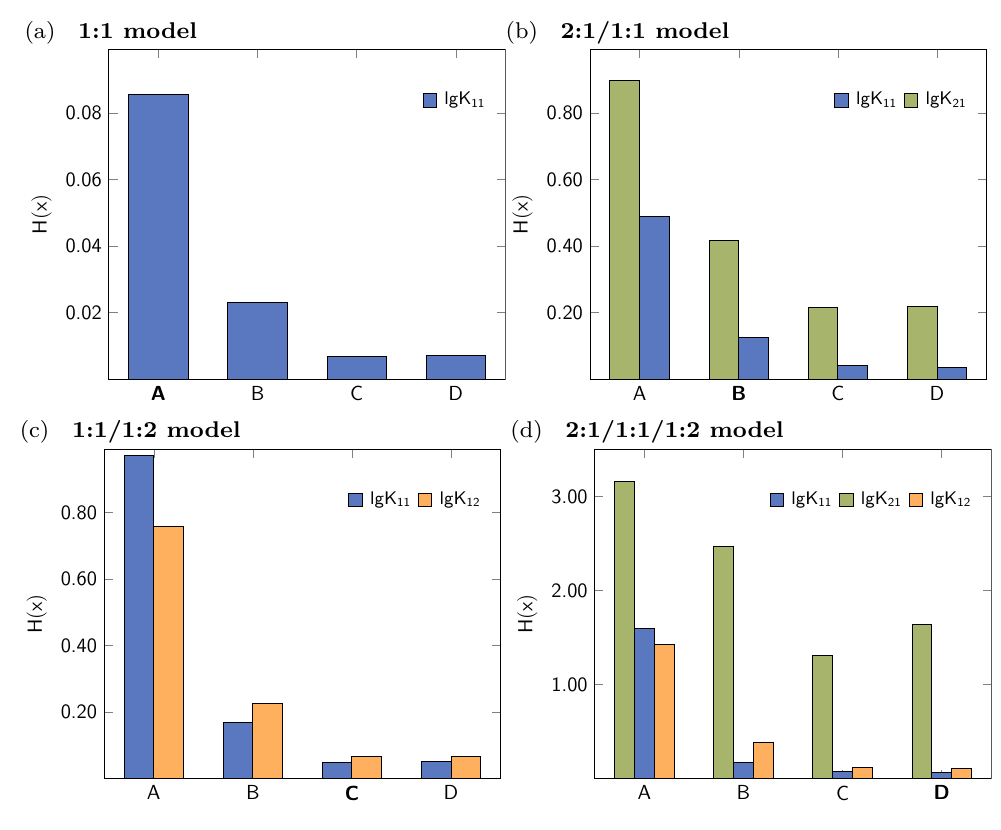
Figure 4 Comparison of different Shannon entropy values. Each bar in the charts corresponds a Monte Carlo simulation with σ MC according to the assigned letter. The letter is typed bold if σ MC = SE y coming from the original model. The SE y input for the calculations are (A) SE y = 0.01708, (B) SE y = 0.00388, (C) SE y = 0.00106, (D) SE y = 0.00108. Full-size DOI: